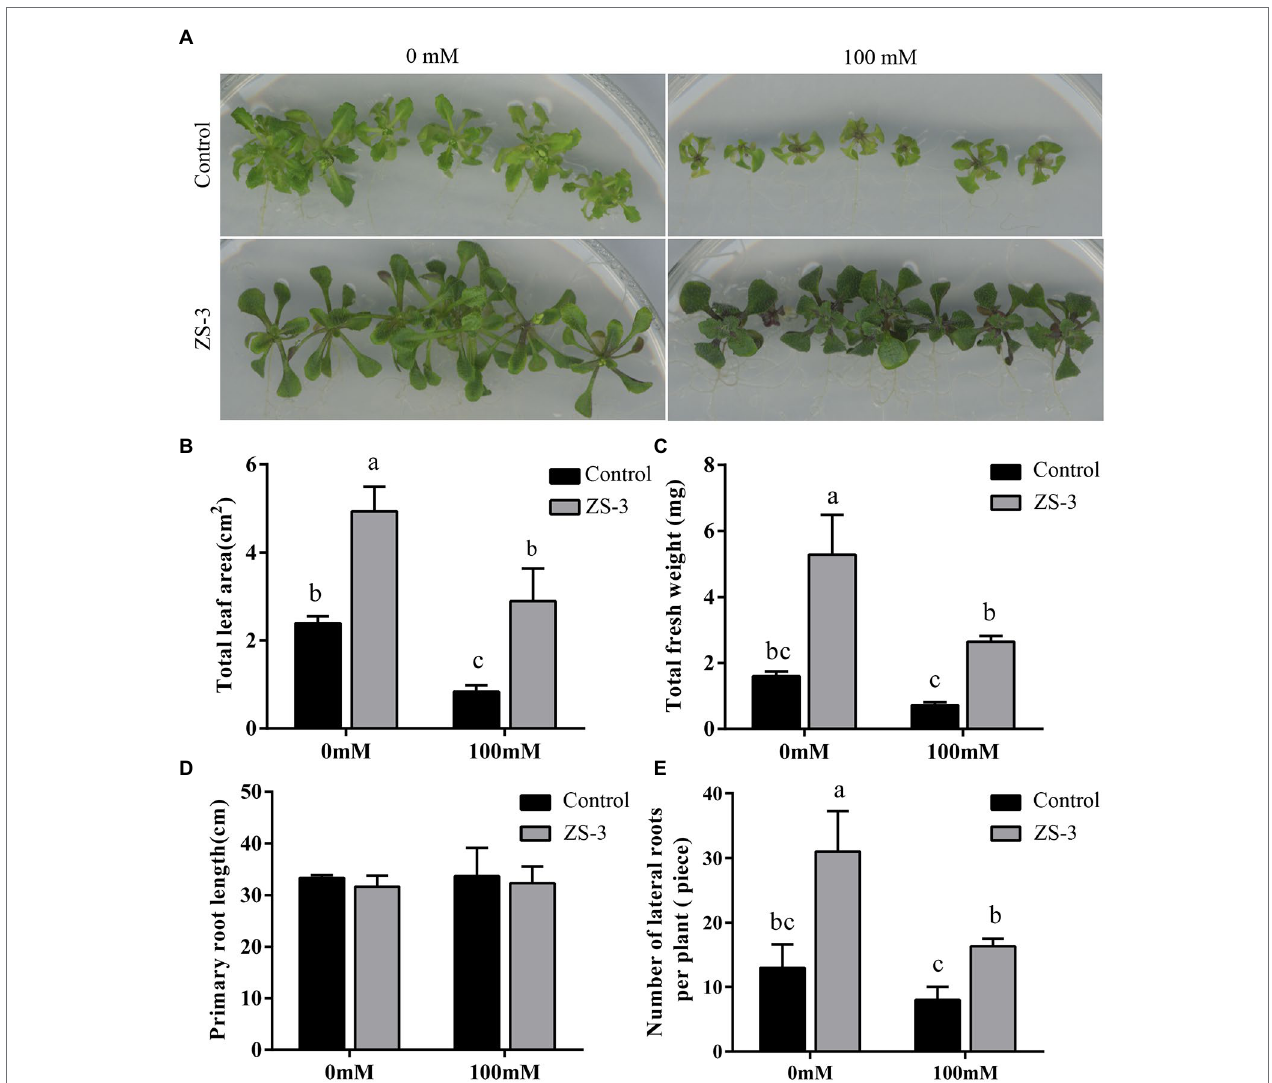
FIGURE 1 | Inoculation with ZS-3 increases biomass in Arabidopsis thaliana . Plants were treated with salt stress for 14 days, pictures (A) were collected, and the plants were analyzed for total leaf area (B) , total fresh weight (C) , primary root length (D) , and lateral root number (E) . The results are the mean ± standard deviation from three independent experiments. Different lowercase letters above the bars represent significant differences based on one-way ANOVA (Duncan’s multiple range, p <